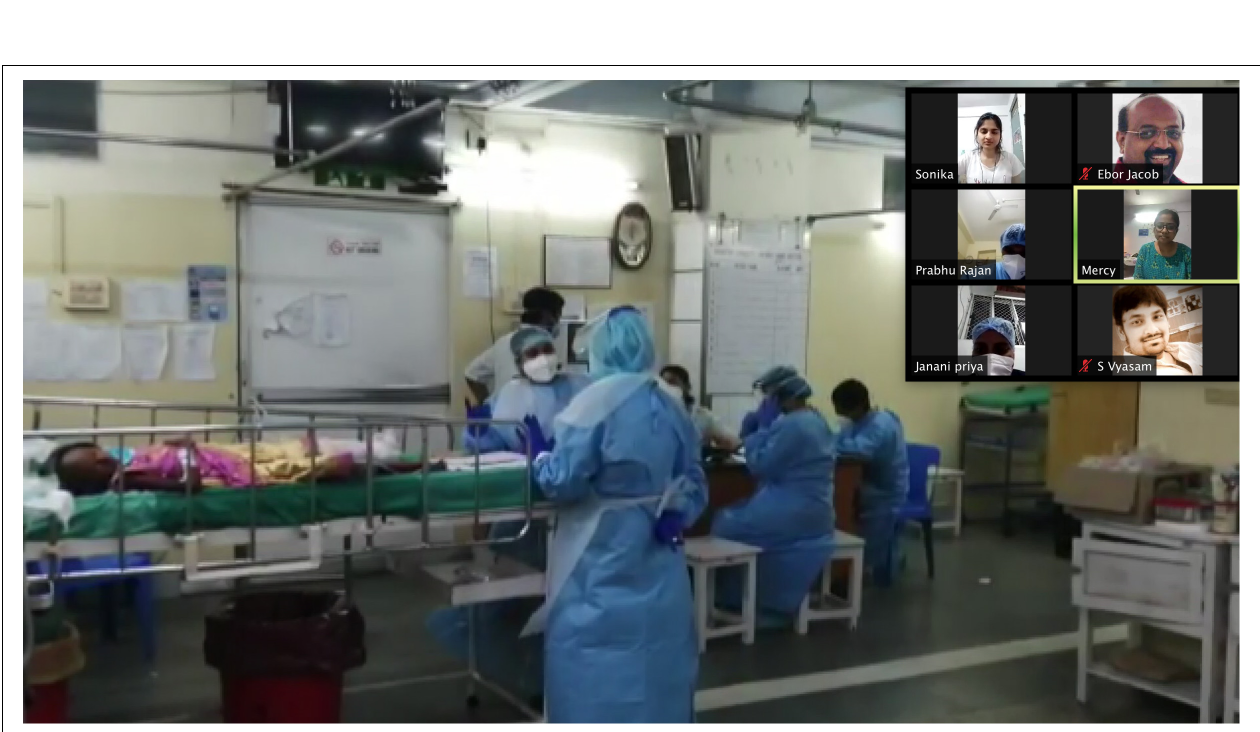
FIGURE 3 | Telesimulation session showing video of a real healthcare teams in the emergency room responding to a patient with shock.